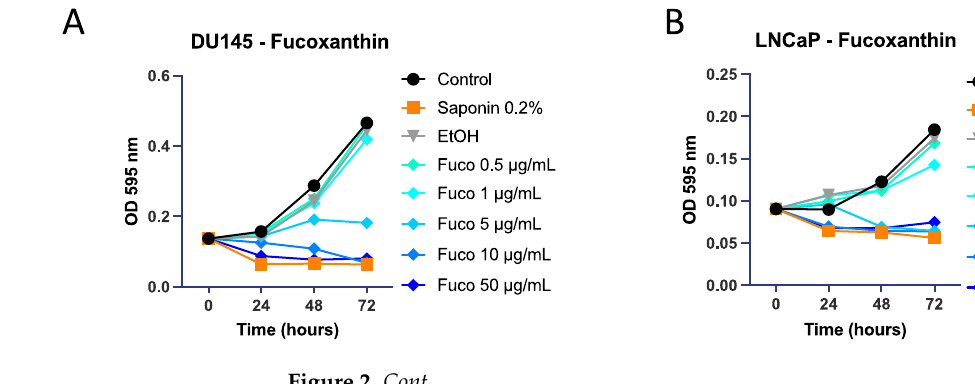
Figure 2. E ff ects of fucoxanthin pigment on PCa cell line proliferation. DU145 ( A ) and LNCaP ( B ) cells were treated with fucoxanthin (Fuco) at 0.5, 1, 5, 10, and 50 µg/mL for 24, 48 and 72 h. The proliferation rate was measured by crystal violet assay (OD 595 nm). Results are shown as mean ± SEM, one-way ANOVA, ns = not signi fi cant, ** p < 0.01, *** p < 0.001, **** p < 0.0001 ( n = 8). 3.2. Identi fi cation of Apoptosis on DU145 Cells We tested whether the reduced proliferation of DU145 PCa cells following treatment with Sm extract and Fuco was associated with the induction of apoptosis. We found that Sm at 100 µg/mL was able to induce early apoptosis and 200 µg/mL could induce late